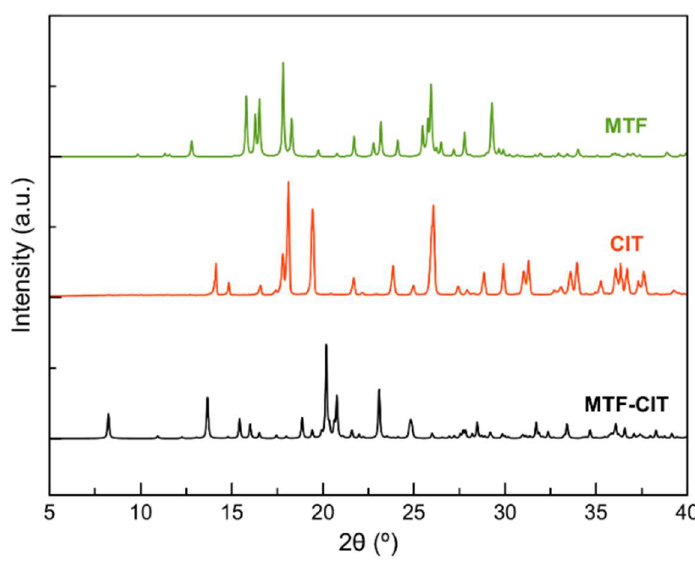
Figure 2. PXRD patterns of MTF (green), CIT (red) and MTF–CIT (black).